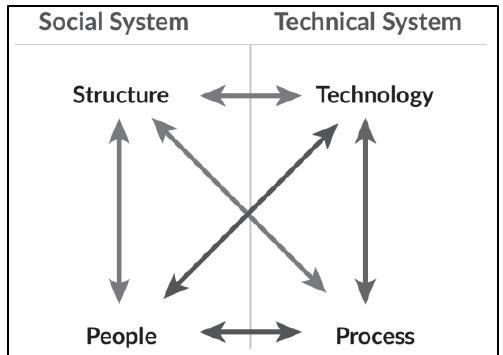
Figure 1. Socio-Technical System Framework (STS Framework)